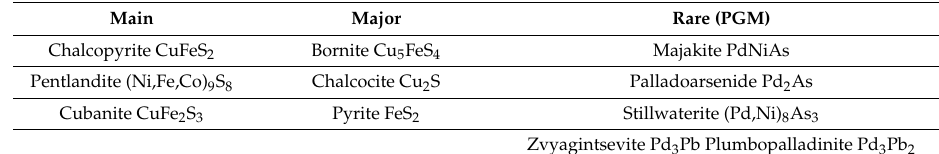
Figure 10. Photomicrographs of the ore from South-Western branch of the Talnakh intrusion. Borehole EМ-6: ( a – f )—massive ore, ( g , h )—disseminate ore. Minerals: Bn—bornite, Cc—chalcocite, Vil—violarite, Cub—cubanite. Table 4. Minerals of the Southern 2